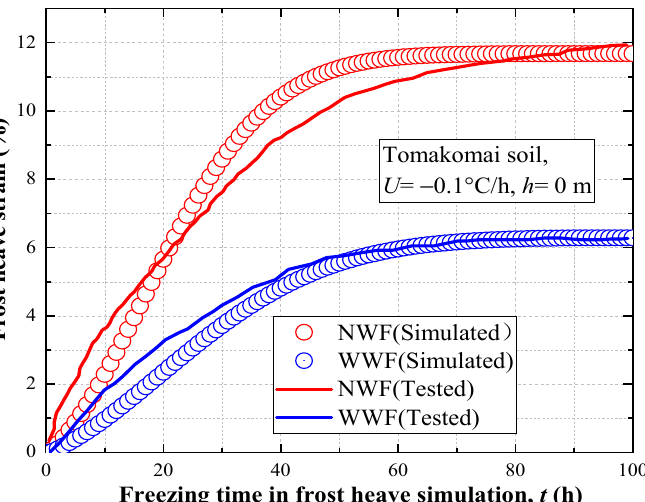
Figure 8. Comparison between numerical and experimental results of frost heave strain for frost heave tests of Tomakomai soil.